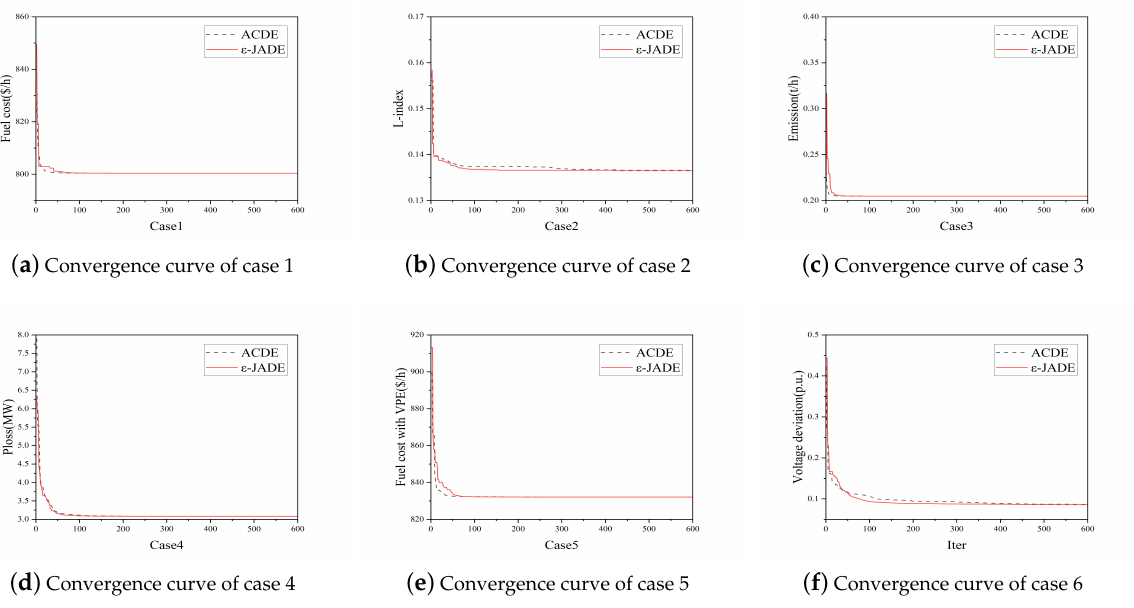
Figure 2. Convergence curve of improved (cid:101) JADE and